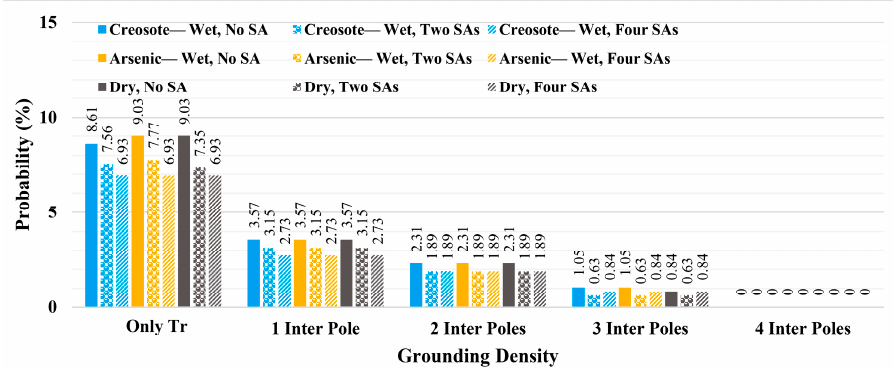
Figure 28. Comparison among the probabilities of transformers experiencing overvoltage stress above 125 kV under different grounding densities of intermediate poles (Inter Pole) and considering two and four surge arresters (SAs); Network with dry poles.